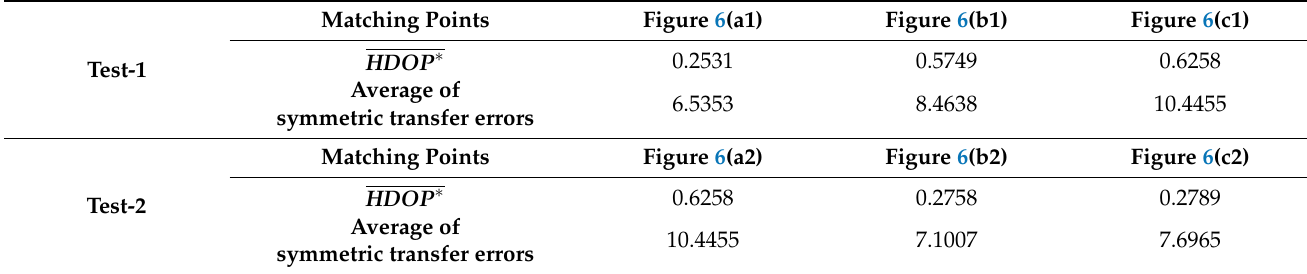
Figure 6. Data source of the real scene. There are about 150 pairs of known matching points extending from the center to the upper-right corner of overlapping region in ( a1 – c1 ), extending from the upper-right corner to the entire overlapping region in ( a2 – c2 ). Table 3. Results calculated by the matching points in Figure